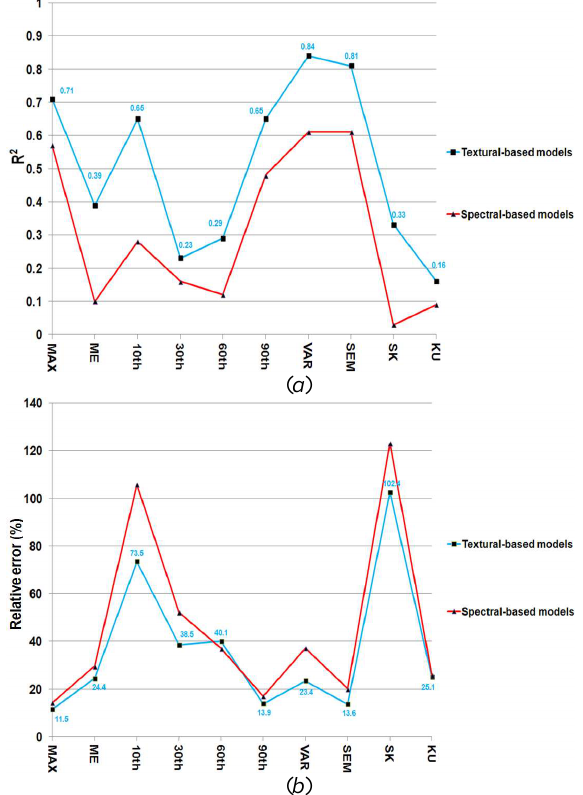
Figure 3. Lidar attributes derived using spectral and textural data of WV-2 multispectral images. ( a ) and ( b ) are for the correlation of determination and relative error respectively derived for the predicted lidar-derived attributes from the test sample plots.